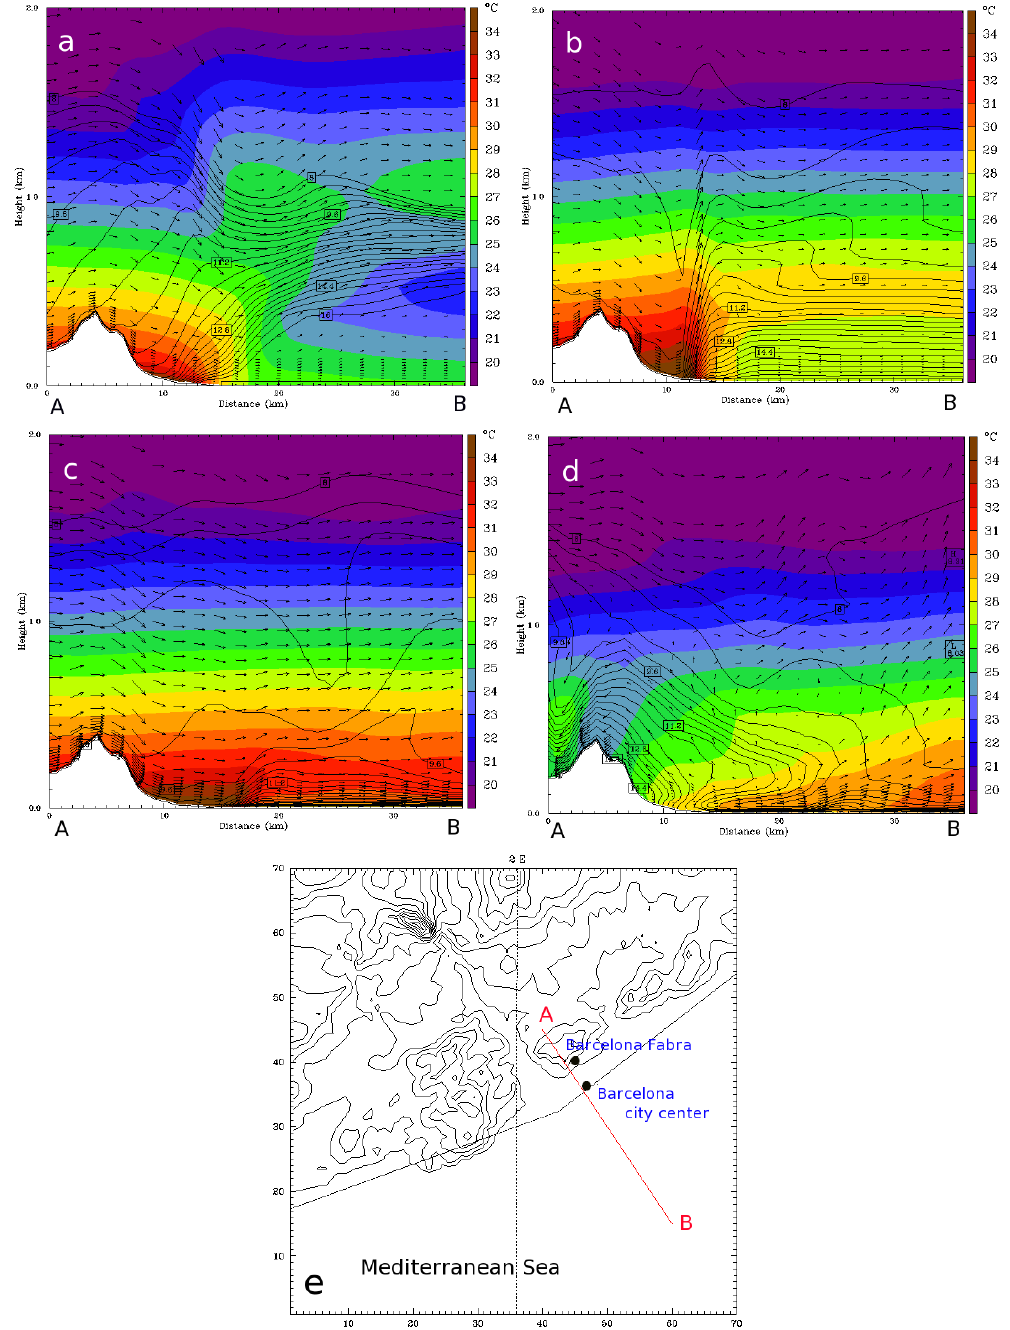
Fig. 4. (a–d) Vertical cross section along the line AB shown in (e) of the simulated temperature (color contour), water vapor–mixing ratio (black lines) and wind field (arrows) at (a) 10:00, (b) 12:00, (c) 15:00, and (d) 18:00 UTC on 27 August 2010. (e) Orography of the smallest domain of the simulation.